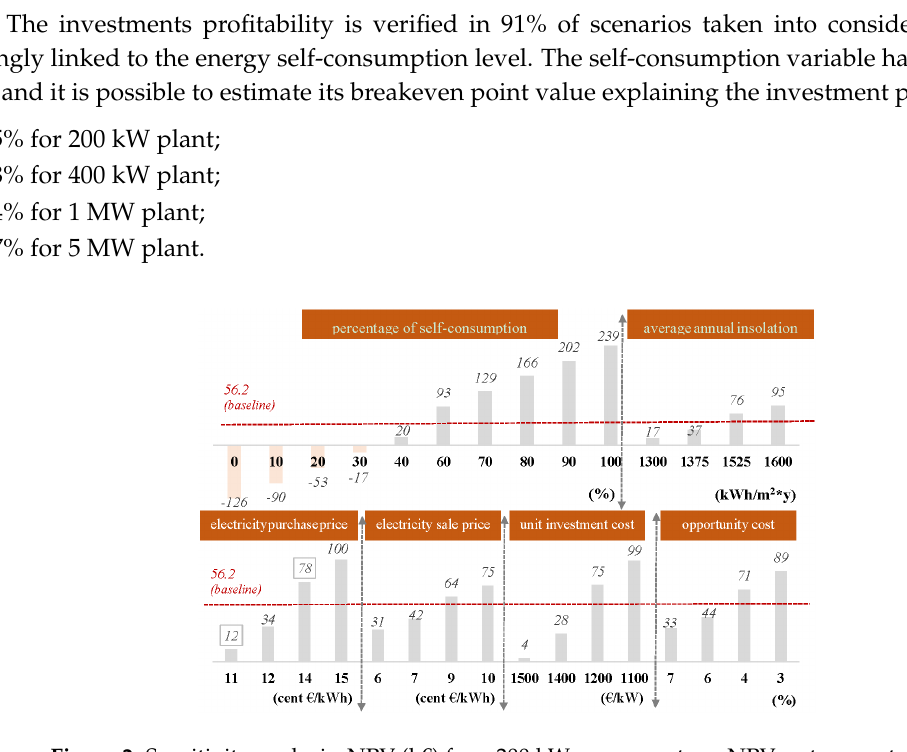
Figure 3. Sensitivity analysis–NPV (k€) for a 400 kW power system.